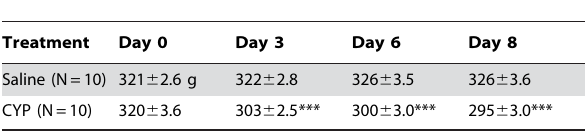
Table 1. Effect of cyclophosphamide on body weight (g)